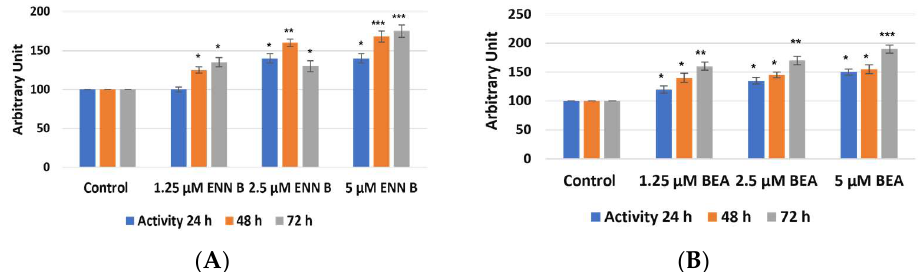
Figure 10. Impact of ENN B and BEA on proteolytic activities of Cathepsin B in media (extracellu- lar). ( A ) cathepsin B activities were measured using cathepsin B specific substrate Z-R-R.AMC in media after treatment with different ENN B concentrations at different times. ( B ) Cathepsin B activities were measured in media after treatment with different concentrations of BEA at different times. The data were analyzed using two-way ANOVA with Dunnett’s post hoc analysis (* p < 0.05; ** p <